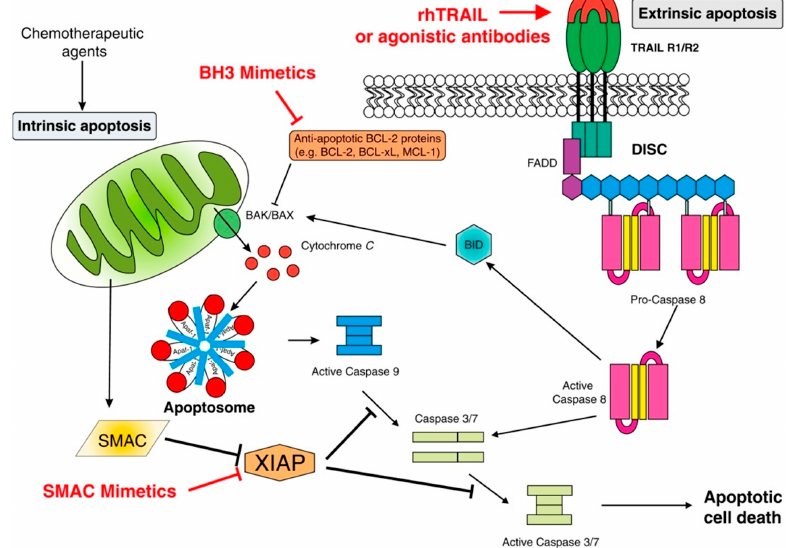
Figure 1. Intrinsic and extrinsic apoptotic signalling pathways and points of therapeutic intervention. Apoptosis can be initiated by signals originating from either the plasma membrane via death receptor ligation (extrinsic pathway) or at the mitochondria (intrinsic pathway). Stimulation of the extrinsic pathway by tumor necrosis factor (TNF)-related apoptosis-inducing ligand (TRAIL) results in TRAIL receptor (TRAIL-R) aggregation and formation of the death-inducing signaling complex (DISC), in which pro-caspase 8 becomes activated and initiates apoptosis by direct cleavage of downstream effector caspases. The addition of either agonistic TRAIL-R1/R2 antibodies or recombinant human TRAIL (rhTRAIL) has been used to trigger the extrinsic pathway for therapy. The intrinsic pathway is regulated by the B cell lymphoma (BCL)-2 family of proteins, which regulate pore formation in the outer mitochondrial membrane and release of apoptogenic factors, such as cytochrome c or second mitochondria-derived activator of caspase (SMAC) from the mitochondria. The release of cytochrome c into the cytosol triggers caspase-9 activation through the formation of the cytochrome c/Apaf-1/caspase-9-containing apoptosome complex. SMAC promotes caspase activation through neutralising the inhibitory effect of integrin-associated proteins (IAPs). The intrinsic pathway has been targeted for therapy either by blocking the inhibitory action of the pro-survival BCL-2 family proteins with BH3 mimetics or by inhibiting the anti-apoptotic action of IAPs with SMAC mimetics. The extrinsic and intrinsic pathways are interconnected, for example, by BID, a BH3 domain-containing protein of the BCL-2 family, which, upon cleavage by caspase-8, triggers intrinsic apoptosis, thereby further amplifying the signal from the extrinsic pathway. Reproduced with the approval of the authors: Fox; MacFarlane. “Targeting cell death signalling in cancer; minimising “Collateral